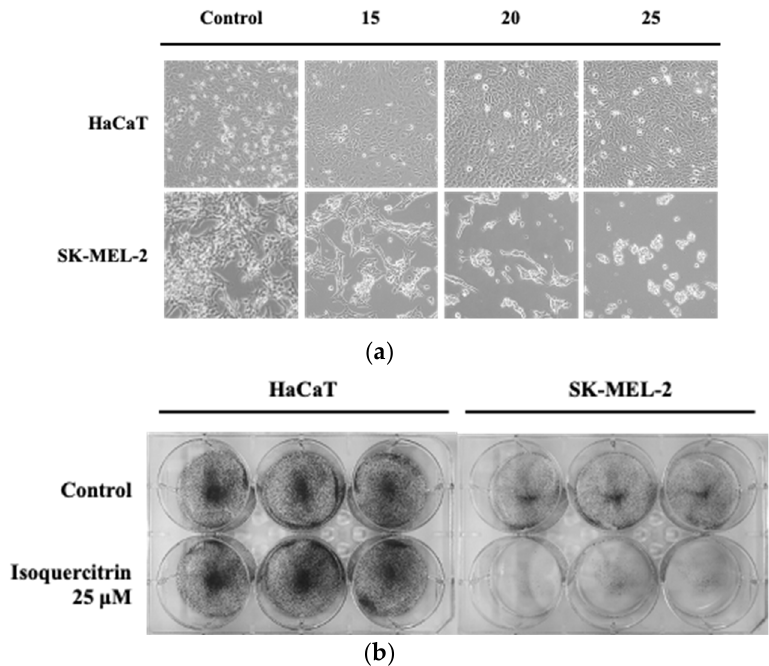
Figure 3. Effect of isoquercitrin on the growth morphology and clonogenicity of SK-MEL-2 cells. HaCaT normal skin cells and SK-MEL-2 melanoma cells were treated with 15, 20, and 25 μM of isoquercitrin. ( a ) After 24 h incubation, the morphology of cells was visualized and compared using an inverted microscope (magnification, 200x). ( b ) Clonogenic assay was performed after incubation for 14 days at 37 °C.